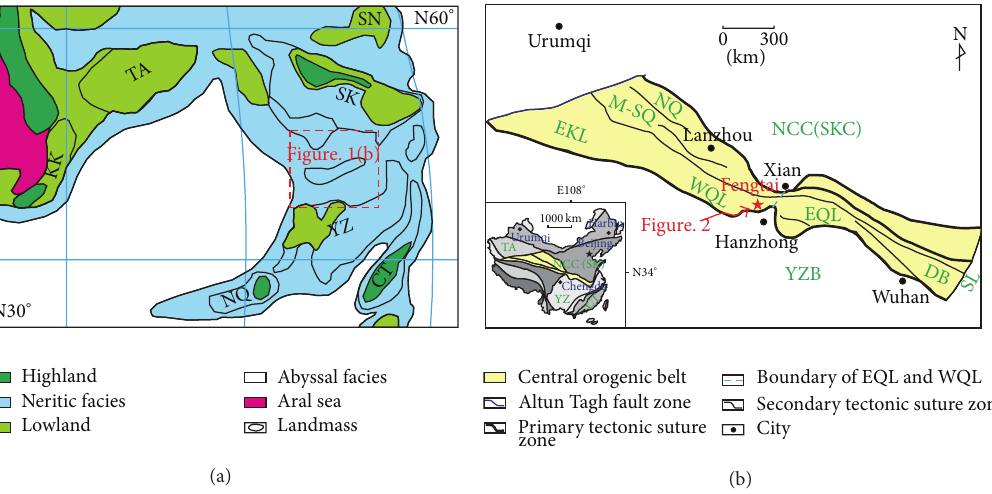
Figure 1: Geographical map and geological sketch of COB and the associated area ((a)—reconstruction map of the Middle-Permian paleo- continents [28]; (b)—geological framework of central orogenic belt [29, 30], TA: Tarim, KK: Karakum, SN: Sonnen, SK: Sino-Korean, YZ: Yangtze, NQ: Northern Qiangtang, CT: Cathaysian, EKL: Eastern Kunlun, M-SQ: Middle-South Qilian, NQ: North Qilian, WQL: Western Qinling, EQL: Eastern Qinling, SKC: Sino-Korean craton, YZB: Yangtze block, and DB:Dabie orogenic